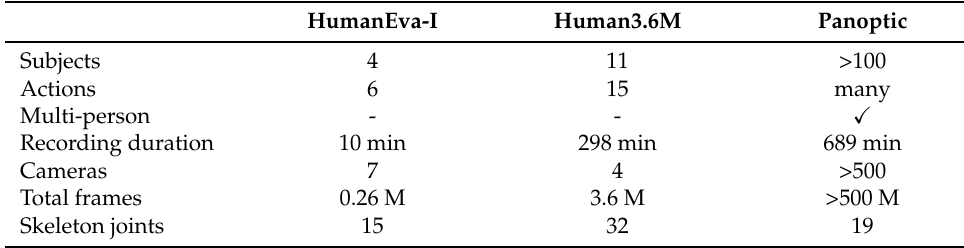
Figure 1. Example images of the HumanEva-I ( left ), the Human3.6M ( middle ), and the Panoptic databases ( right ). Table 4. Quantitative comparison of the